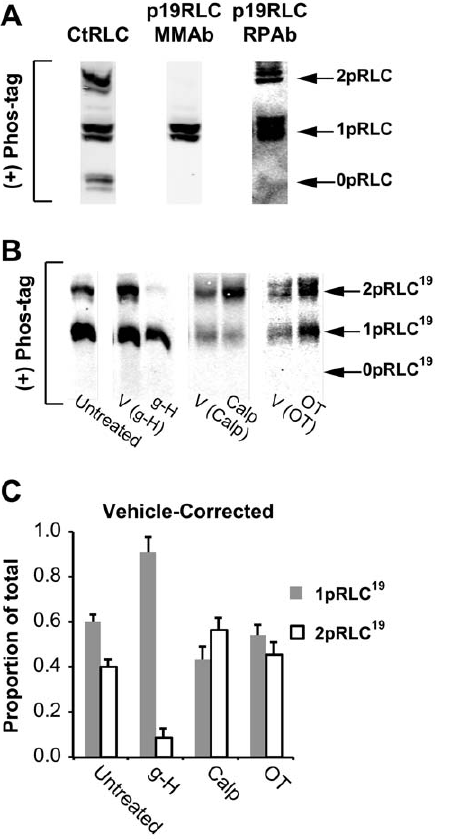
Figure 5. Demonstration of Phospho-S19-RLC phospho-state distribution in uterine myocytes. A. Detection of 0pRLC, 1pRLC and 2pRLC separated by Mn 2 + -phos-tag SDS-PAGE with an Ab toward the C-terminus of RLC (CtRLC) and two Abs (mouse MonoclonalAb [MMAb] and rabbit PolyclonalAb [RPAb]) directed toward phospho-S19- RLC. B. Representative WB demonstrating RLC phospho-states sepa- rated by Mn 2 + -phos-tag SDS-PAGE and probed using PRAb from panel A. Uterine myocytes were lysed and total protein was harvested after the following treatments: untreated, or treated with g-H, Calp, OT, or with their corresponding vehicles. C. Vehicle-corrected distribution data for 1pRLC 19 and 2pRLC 19 obtained by normalizing the data in panel A to the untreated group distribution. g-H (1 m M, n=5). Calp (0.5 mU/mL, n=10). OT (100 nM, n=10). All data are shown as means 6 SEMs. The corresponding numerical data are compiled in Table 2.